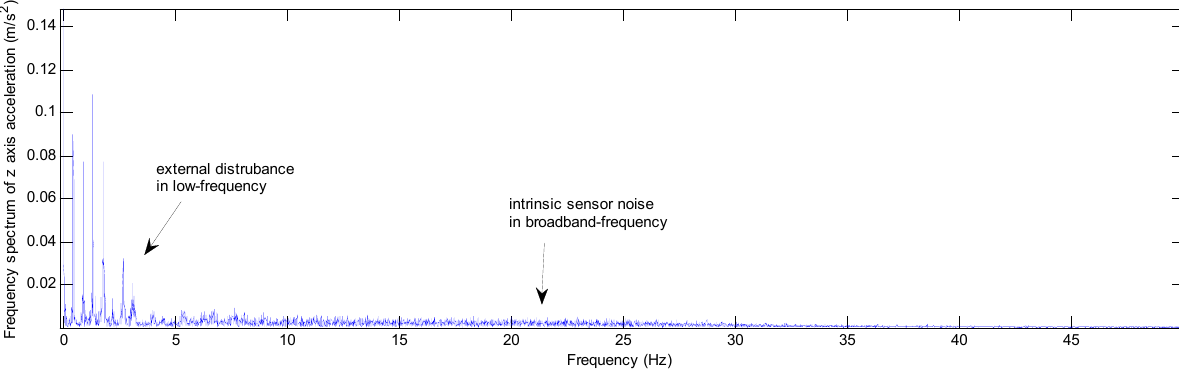
Figure 1. The z axis acceleration frequency spectrum under mooring